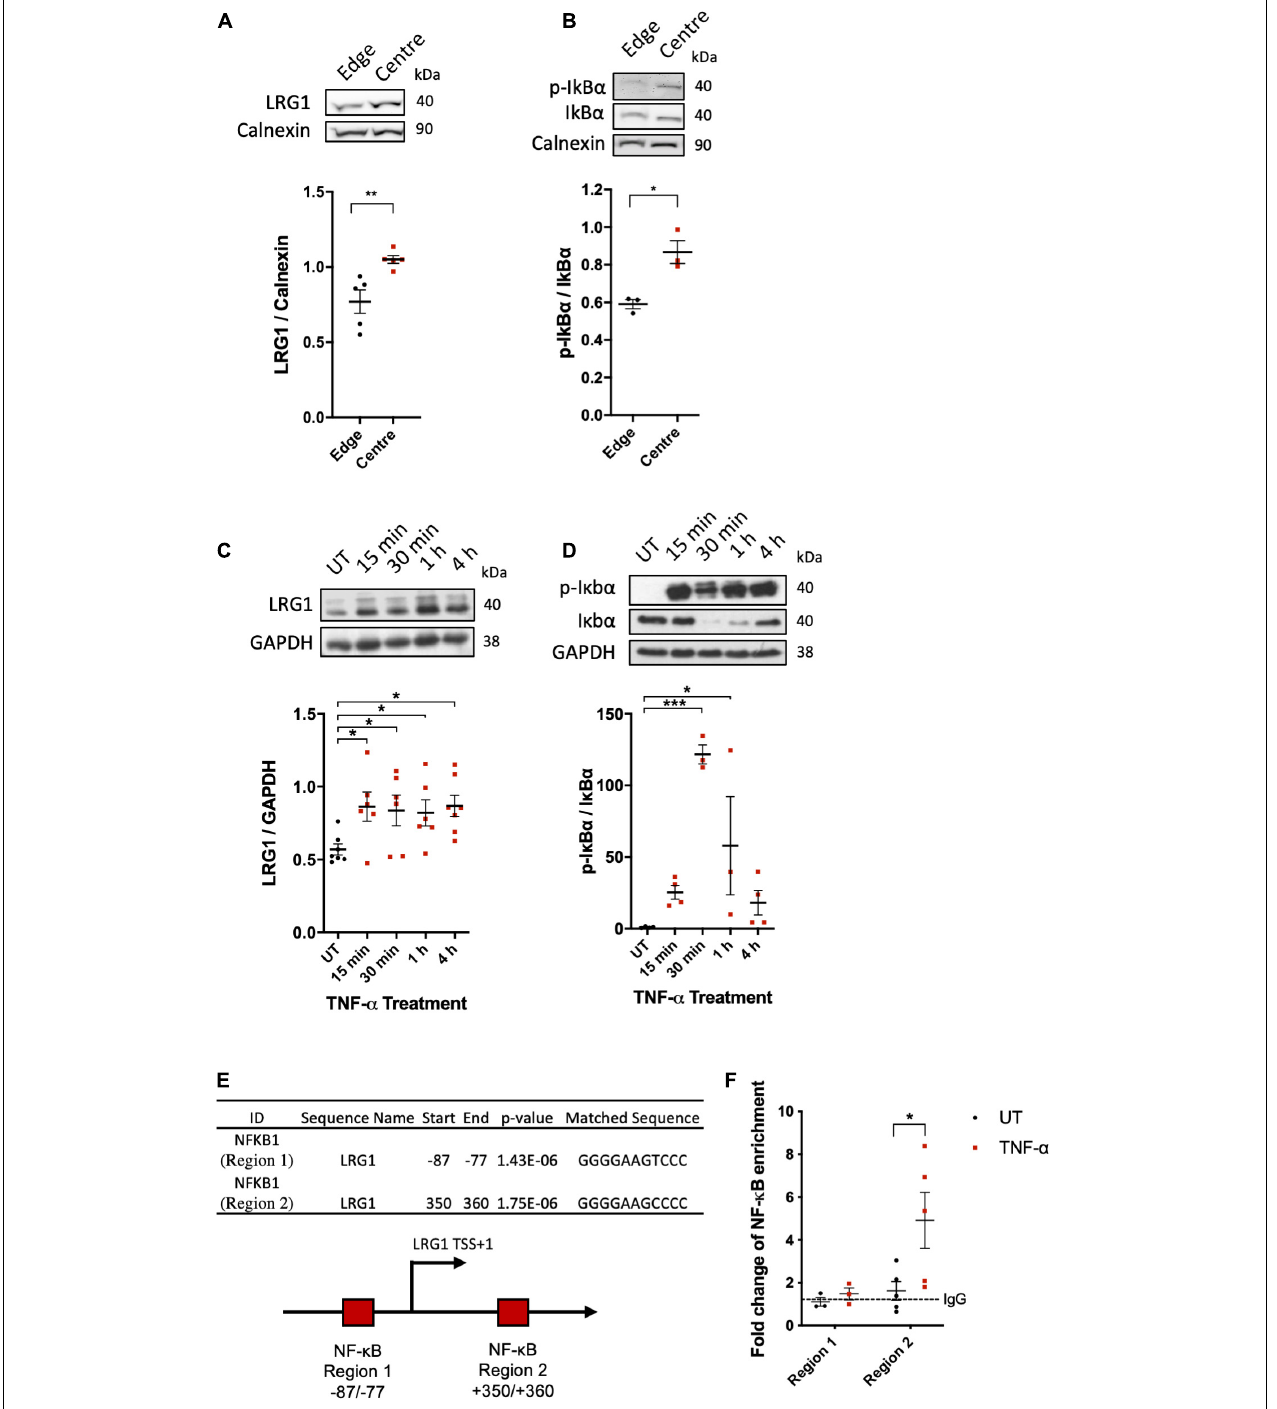
FIGURE 2 | Leucine-rich α -2-glycoprotein (LRG1) protein expression were upregulated in activated EC. Putatively atherogenic flow at the centre of swirled wells upregulated the expression of (A) LRG1 and (B) phospho-IkB α in HUVECs, compared to putatively atheroprotective flow at the edge of the wells. Expression of (C) LRG1 and (D) phospho-IkB α was upregulated in HUVECs by TNF- α . (E) Summary of the motif analysis conducted using FIMO. The schematic diagram shows the 2 kb sequence near the transcription start site (bent arrow) of the LRG1 promoter region containing two putative NF- κ B (RelA) binding sites (red box) predicted by FIMO. (F) ChIP-qPCR analysis of TNF- α -i nduced association between NF- κ B/p65 and the LRG1 promoter in HDMECs. [ (A,B,E) , Unpaired two-tailed Student’s t -test; n ≥ 3. (C) , One-way ANOVA followed by Bonferroni post hoc test; n ≥ 3. * p < 0.05; ** p < 0.01].